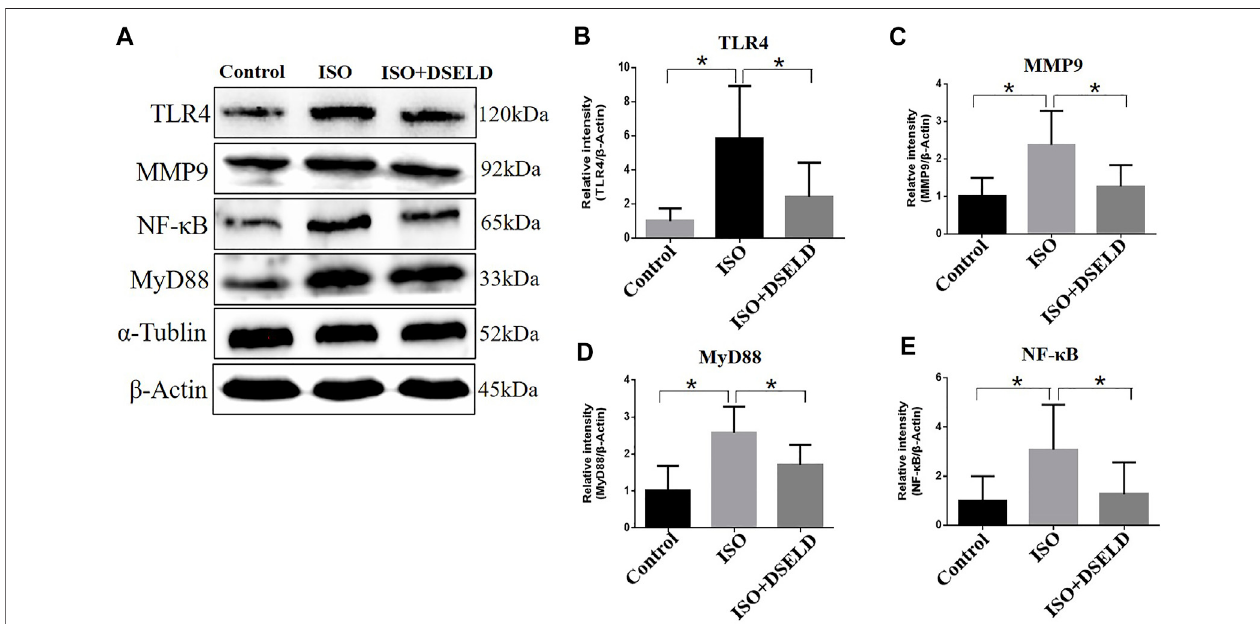
FIGURE 6 | Dangshen Erling decoction (DSELD) inhibits the expressions of Toll-like receptor (TLR)4 signaling pathway proteins. (A) Western blot of TLR4, matrix metalloproteinase (MMP)9, nuclear factor (NF)- κ B, and myeloid differentiation factor (MyD)88 proteins and (B – E) relative expression in the heart samples normalized to control. n (cid:1) 4. *p < 0.05, **p <